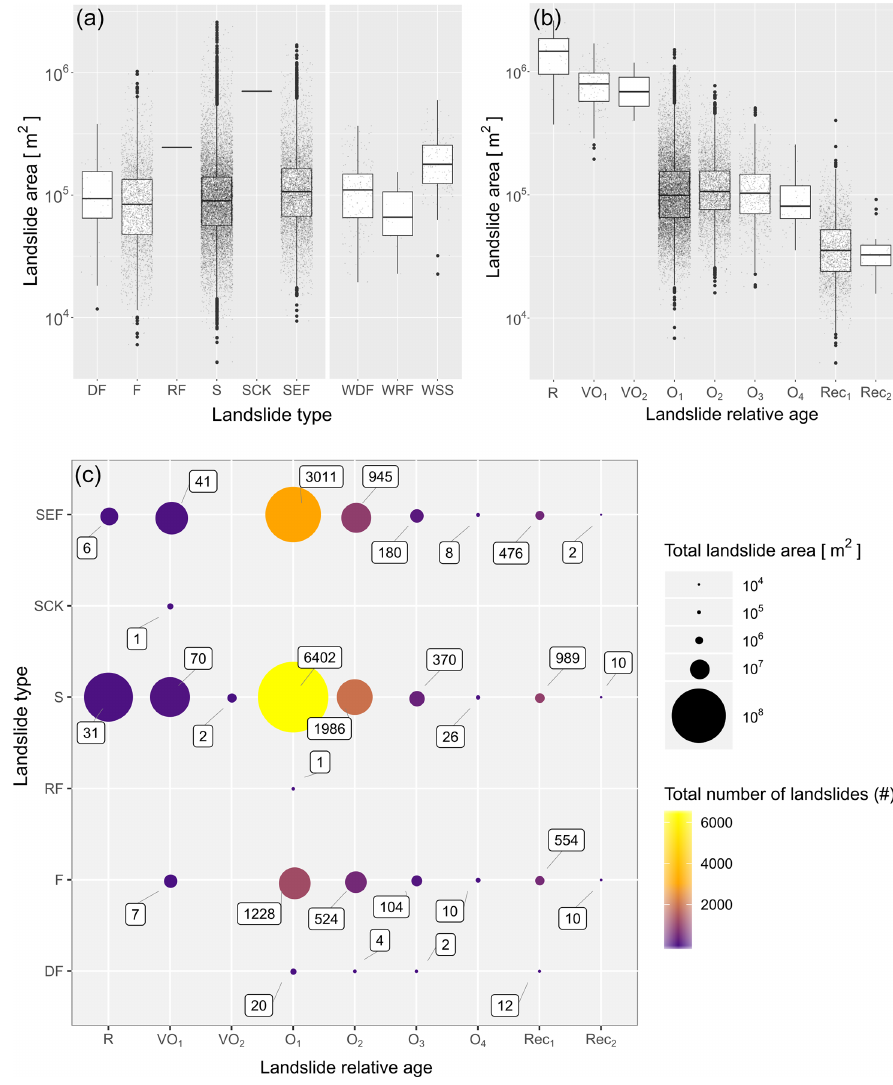
Figure 7. Plots summarising landslide statistics. (a) Landslide number (represented by a colour gradient and labels) and cumulated area (proportional to circle sizes), grouped by relative age class and landslide type (SK, sackung; SEF, slide-earth flow; S, slide; RF, rockfall; DF, debris flow; EF, earth flow). (b) Distribution of landslide areas within each relative age class. The relative age classes are indicated through a letter (R, relict; V, very old; O, old) and a subscript number that indicates the generation within the age class (1–4). (c) Scatterplot showing cumulative sizes and counts of landslides grouped by relative age in the abscissa and type in the ordinate. Landslide number is represented by a colour gradient and labels; total area is proportional to circle